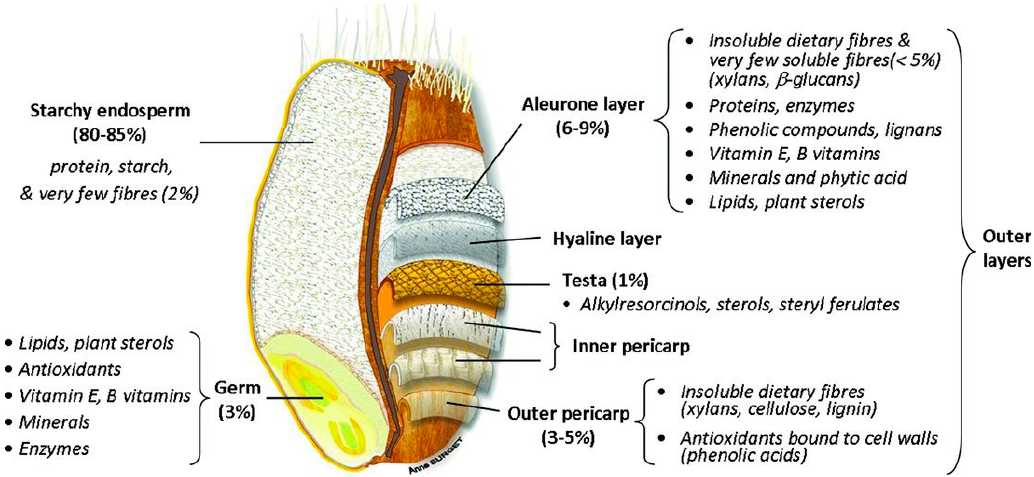
Figure 1. Wheat grain structure [21].